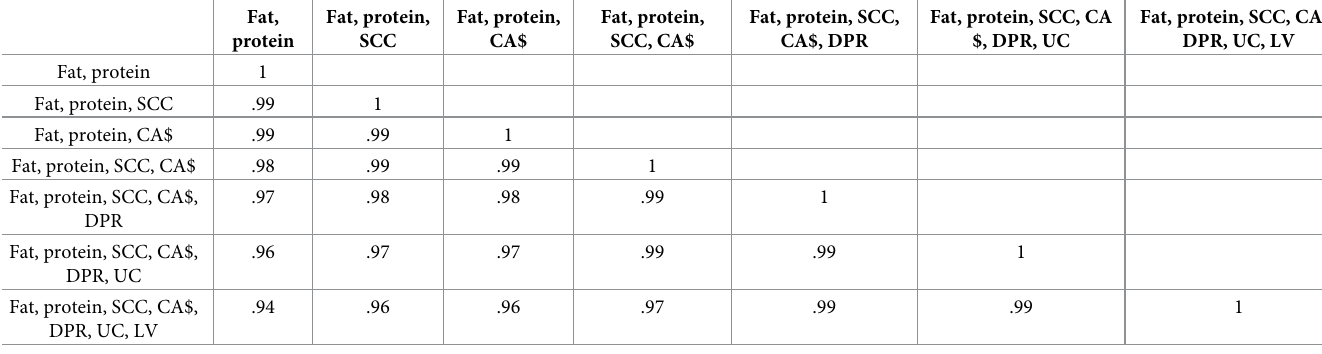
Table 6. Correlations for revenue efficiency for bulls across models using various outputs. Fat, Fat, protein, Fat, protein, Fat, protein, Fat, protein, SCC, Fat, protein, SCC, CA Fat, protein, SCC, CA$, protein SCC CA$ SCC, CA$ CA$, DPR $, DPR, UC DPR, UC, LV Fat, protein 1 Fat, protein, SCC .99 1 Fat, protein, CA$ .99 .99 1 Fat, protein, SCC, CA$ .98 .99 .99 1 Fat, protein, SCC, CA$, .97 .98 .98 .99 1 DPR Fat, protein, SCC, CA$, .96 .97 .97 .99 .99 1 DPR, UC Fat, protein, SCC, CA$, .94 .96 .96 .97 .99 .99 DPR, UC, LV